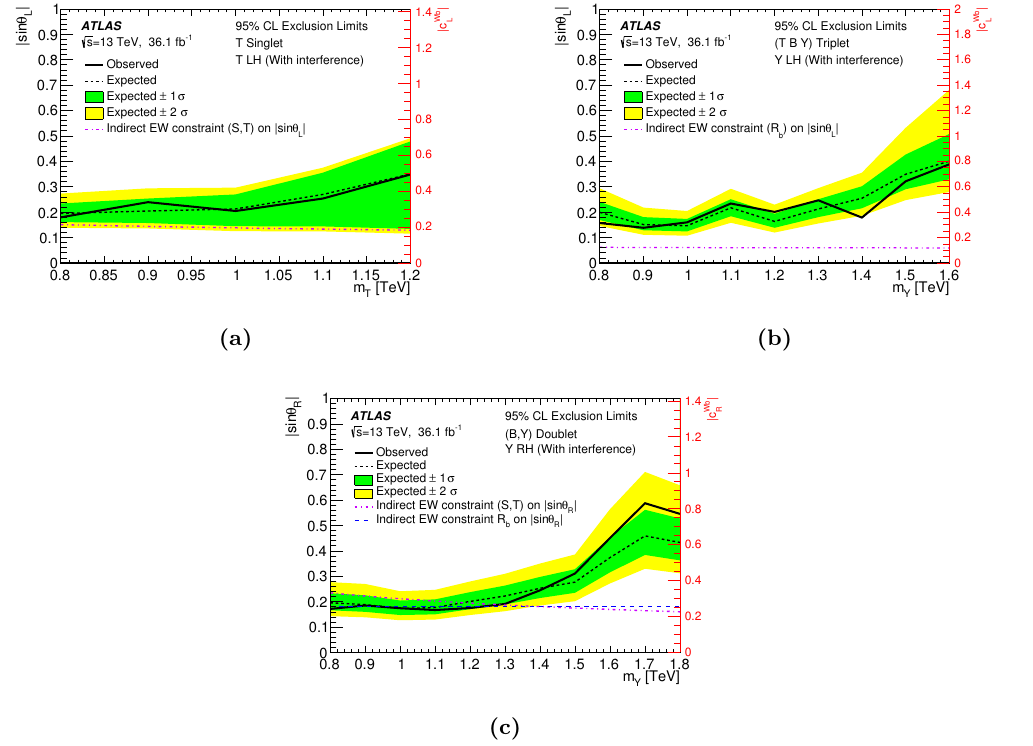
Figure 8. Observed (solid line) and expected (short-dashed line) 95% CL limits on (a) the mixing angle sin (cid:18) L and the coupling value c Wb for a singlet T -quark model assuming ( T Wb ) 0.5, L j j B ! (cid:25) (b) sin (cid:18) L and c Wb for a ( T; B; Y ) triplet model, and (c) sin (cid:18) R and c Wb for a ( B; Y ) doublet model L R j j j j assuming a branching ratio ( Y Wb ) = 1, as a function of the VLQ mass. The surrounding bands B ! correspond to 1 and 2 standard deviations around the expected limit. The excluded region is (cid:6) (cid:6) given by the area above the solid line. Constraints from electroweak precision observables, which are only valid for the mixing angles, from either the S and T parameters (dashed-dotted line) or from the R b values (long-dashed line), are also shown. These constraints are taken from ref. [1], where they are presented as a function of m B (in the ( B; Y ) doublet case), respectively, m T (in the ( T; B; Y